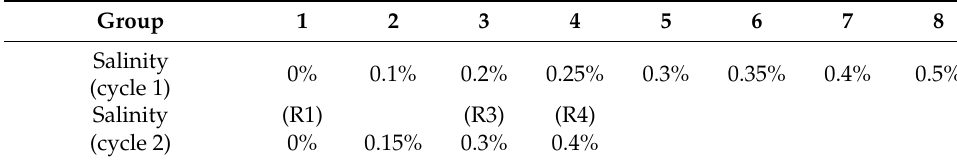
Table 1. Concentration setting of two-cycle